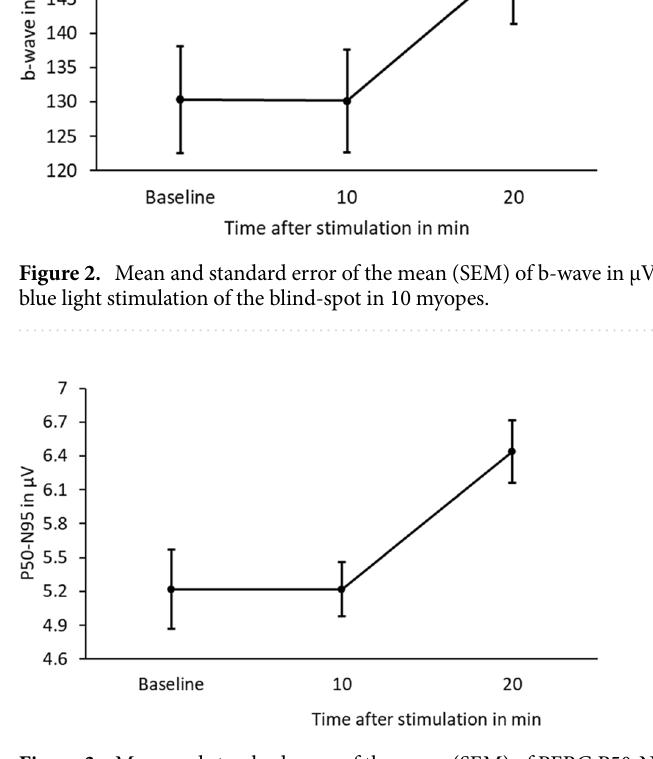
Figure 3. Mean and standard error of the mean (SEM) of PERG P50-N95 in µV of baseline and 10 and 20 min after blue light stimulation of the blind-spot in 5 myopes.